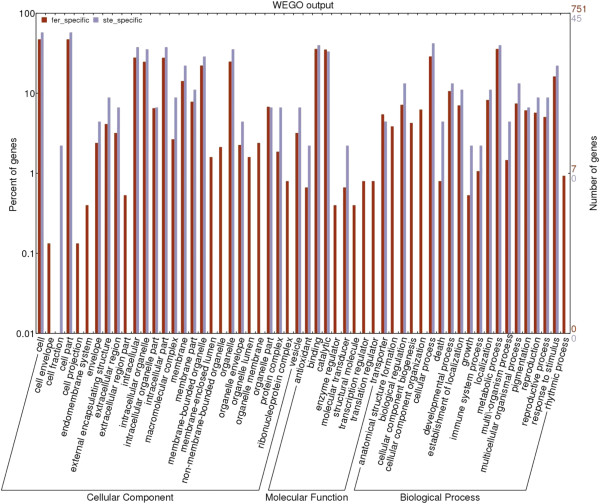
Histogram showing GO analysis of DEGs which specific to Fer or Ste in B. rapa.